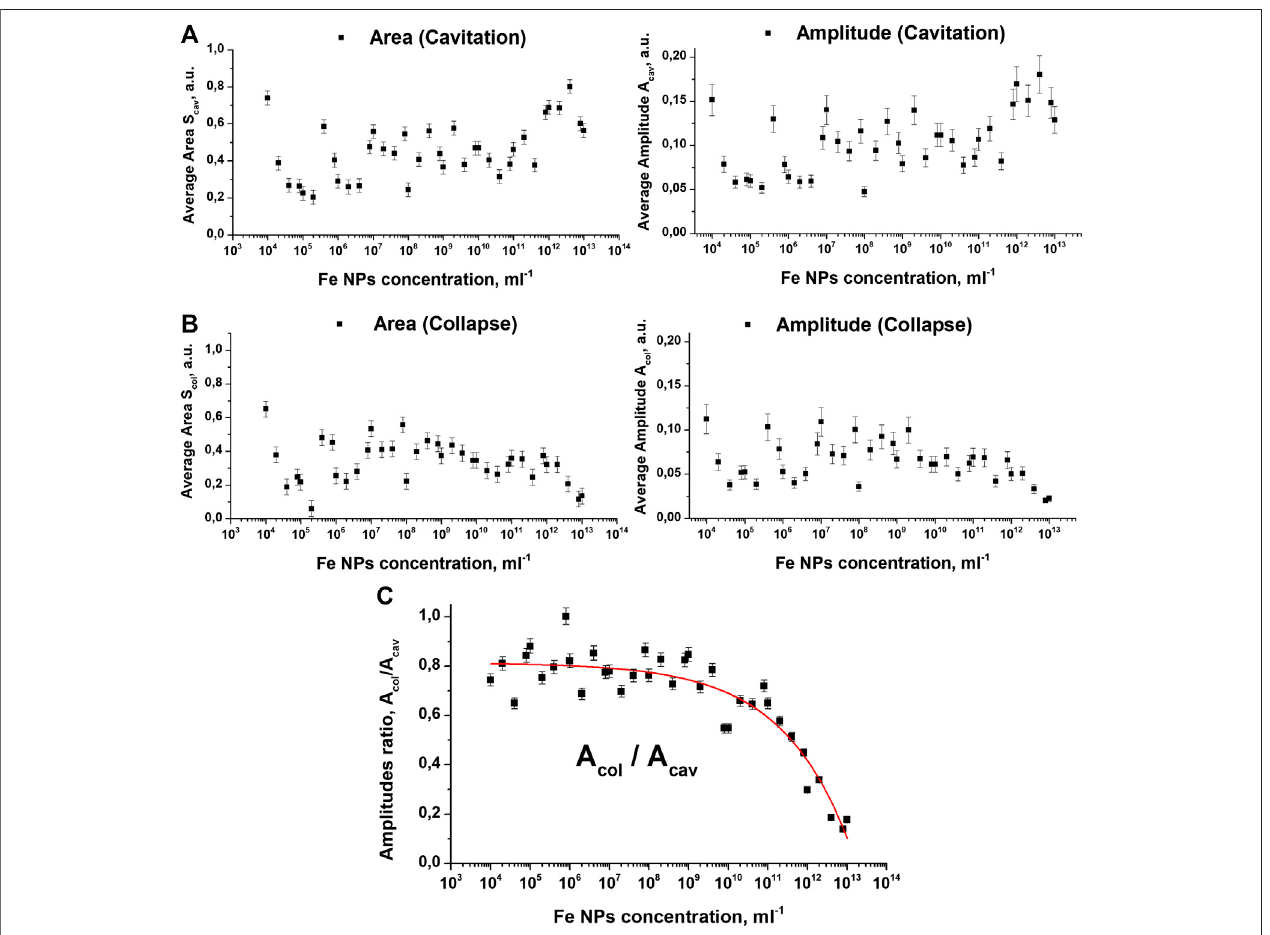
FIGURE 3 | Dependence of the areas and amplitudes of acoustic signals on the concentration of Fe nanoparticles in the case of: (A) cavitating gas bubbles; (B) collapsing gas bubbles and (C) the ratio of the amplitudes of the acoustic signals.